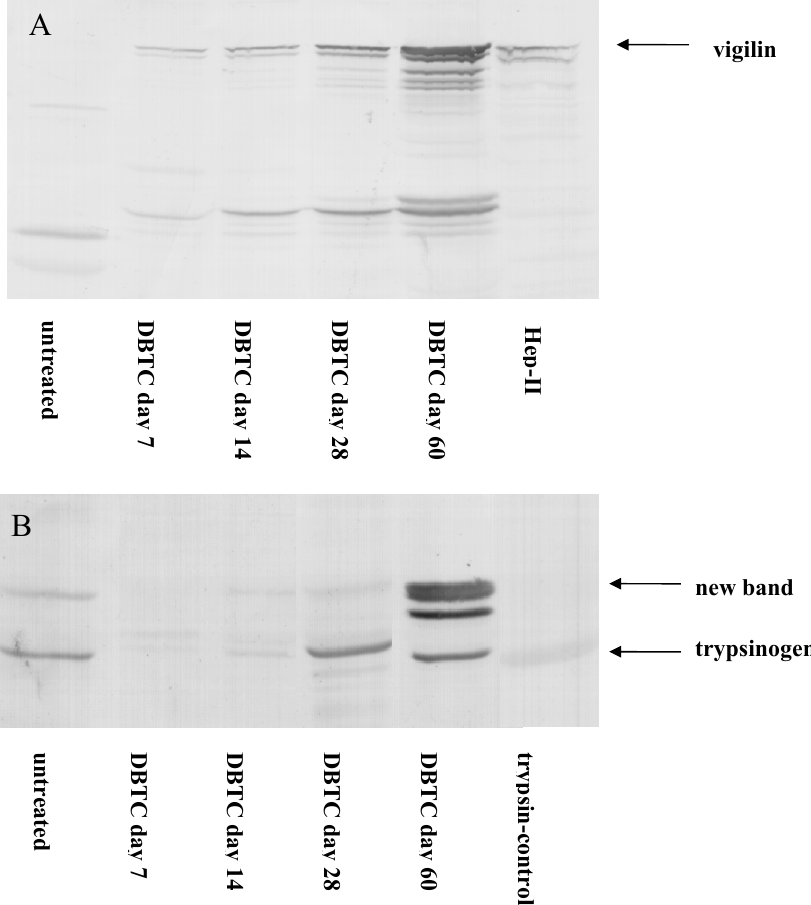
Fig. 2 Identification of vigilin (A) and trypsin(ogen) (B) by immunoblotting in super- natants of homogenised and centrifuged pancreata from untreated rats and rats after induction of chronic pancreatitis by dibutyltin dichloride